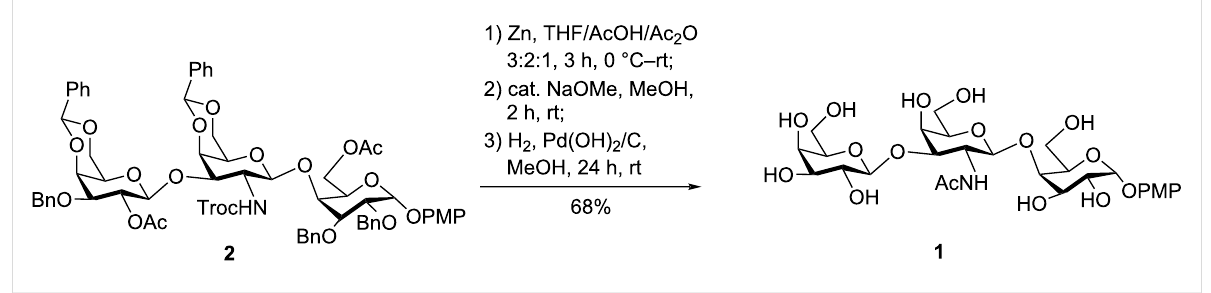
Scheme 5: One-pot synthesis of trisaccharide derivative 2 .